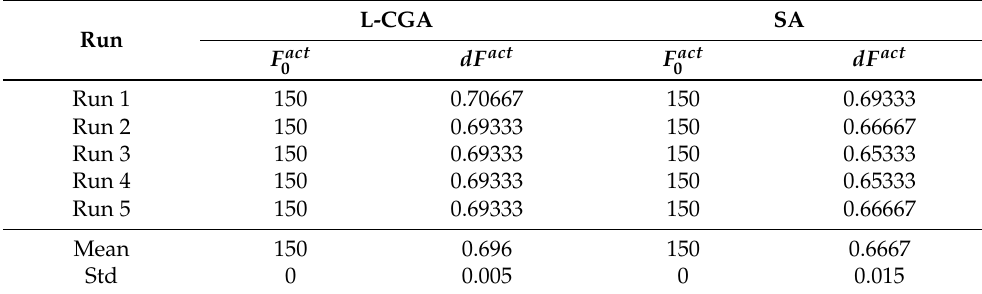
Table 6. Comparison of resonator characteristics achieved by L-CGA and SA, 3 mode